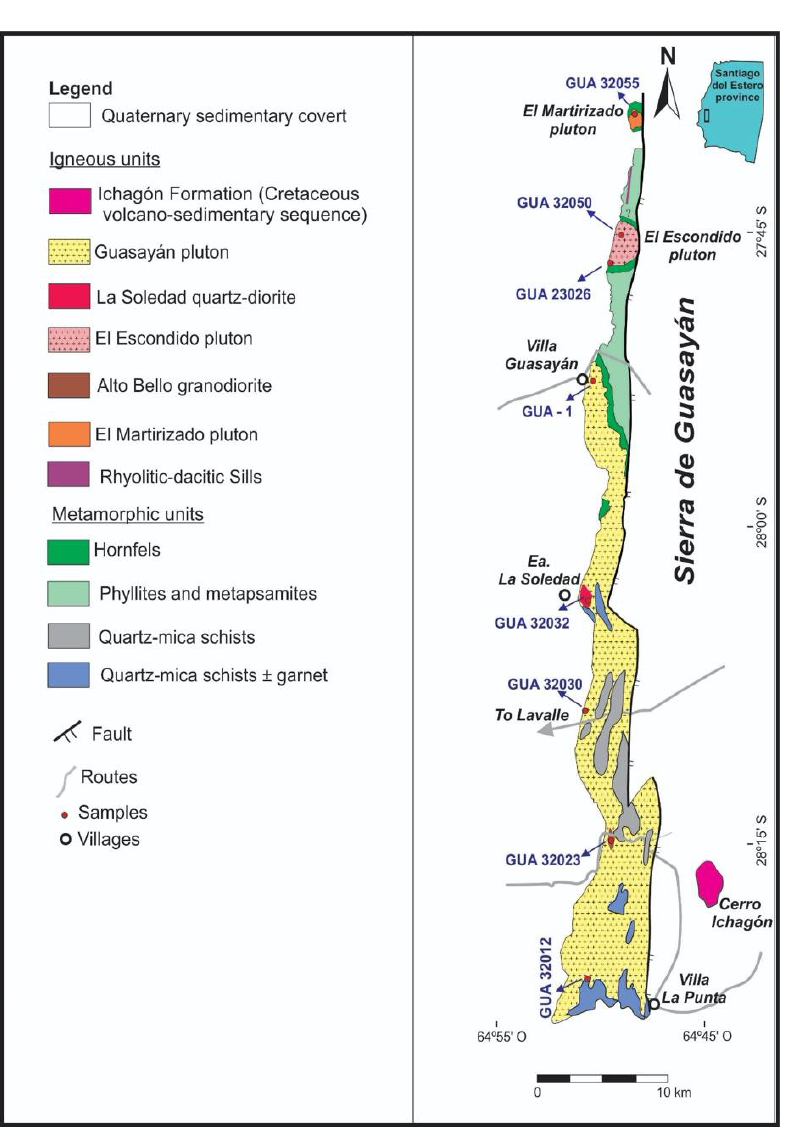
Figure 2. Geological sketch of the Sierra de Guasayán with location of the studied samples. Location of sample GUA-1 from Dahlquist et al. [43] is also indicated.